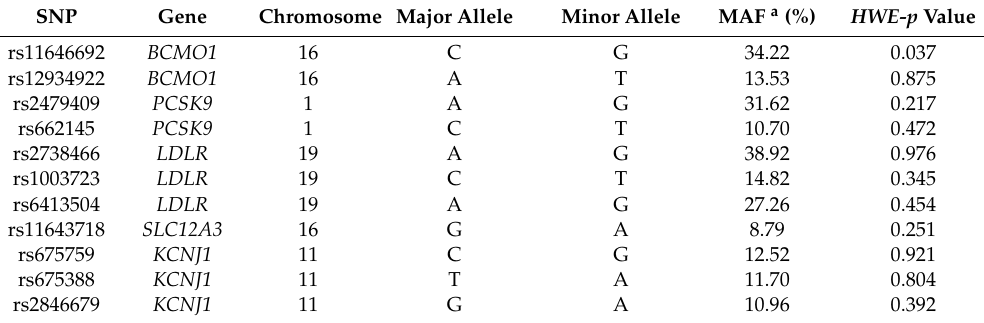
Table 2. Test of the Hardy–Weinberg equilibrium and allele